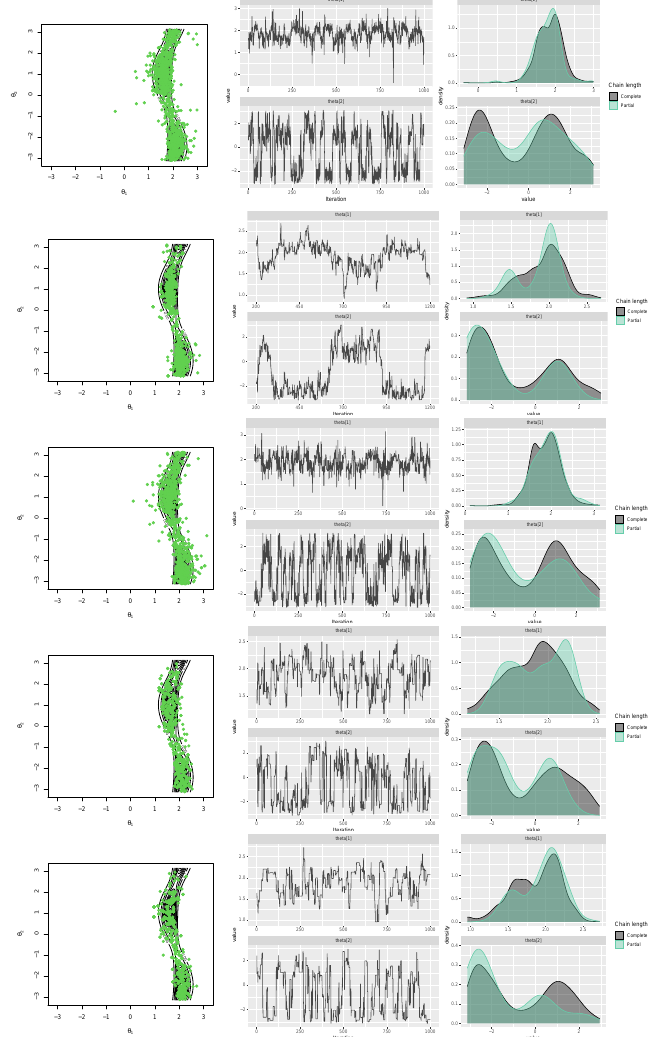
Figure 13. Scatter, trace, and compare-partial plots of the simulated data from the transformed sine model using “gibbs_met” in the “gibbs.met” package (first row), “MCMCmetrop1R” in the “MCMCpack” package (second row), “met_gaussian” in the “gibbs.met” package (third row), “Metro_Hastings” in the “MHadaptive” package (fourth row), and “rwmetrop” in the “LearnBayes” package (fifth row).